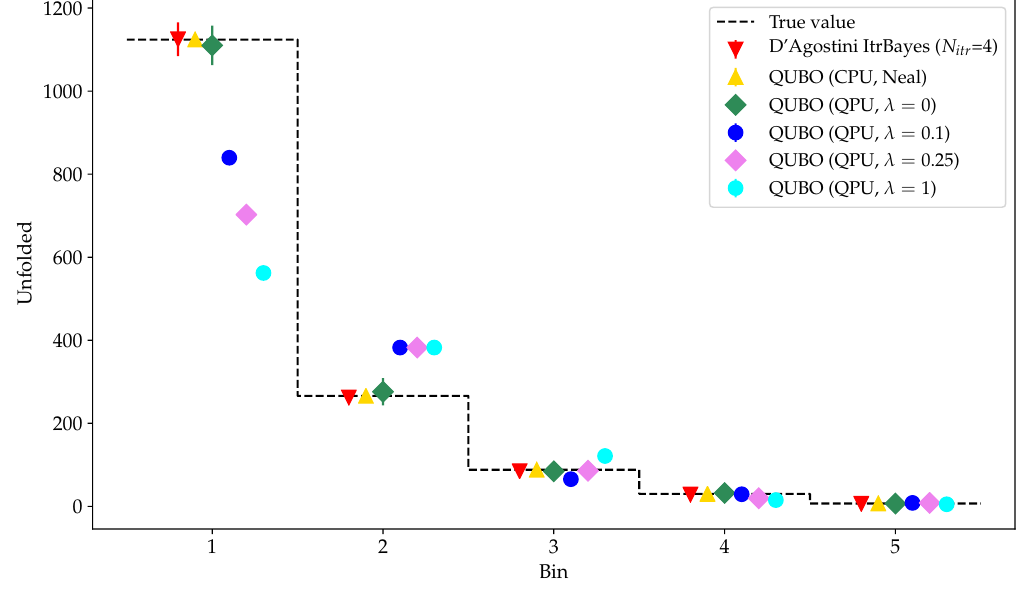
Figure 3 . Truth-level distribution of pseudo-data, unfolded with di(cid:11)erent methods and values of the regularization strength (cid:21) , of a steeply-falling spectrum. The data corresponding to runs submitted to the QPU are averaged over 20 executions with 5000 reads